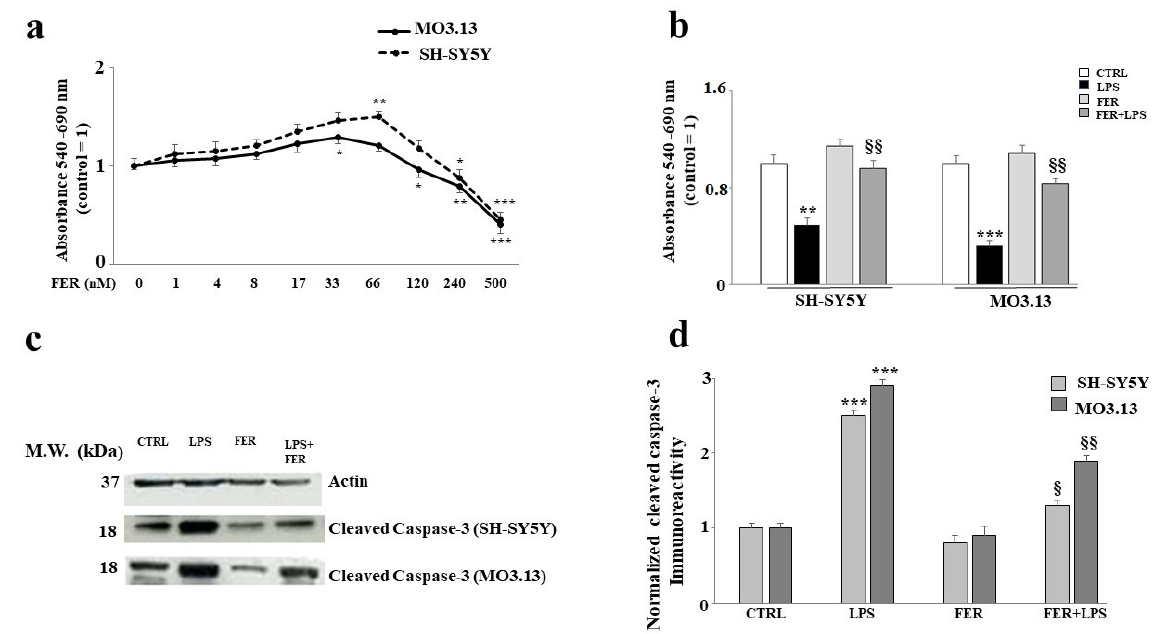
Figure 3. Role of FER in LPS-induced damage. In panel ( a ), a dose–response curve is shown for co-cultured neurons and oligodendrocytes exposed to increasing concentrations of FER over 24 h. The results made it possible to select a 33 nM dose of FER for our experimental model. Three independent experiments were carried out, with the values expressed as the mean ± standard deviation (sd). * denotes p < 0.05 vs. the control; ** denotes p < 0.01 vs. the control; *** denotes p < 0.001 vs. the control. Analysis of Variance (ANOVA) was followed by a Tukey–Kramer comparison test. Panel ( b ) shows the reversal effect of LPS-induced damage by FER, similar to that generated by 17- β -E2. Three independent experiments were carried out, and the values are expressed as the mean ± standard deviation (sd). ** denotes p < 0.01 vs. the control; *** denotes p < 0.001 vs. the control; §§ denotes p < 0.01 vs. LPS. Analysis of Variance (ANOVA) was followed by a Tukey–Kramer comparison test. In panel ( c ), the expression of cleaved caspase 3 in both cell lines (based on the indicated treatments) is displayed. Relative quantification is highlighted in panel ( d ). Three independent experiments were carried out, and the values are expressed as the mean ± standard deviation (sd). *** denotes p < 0.001 vs. the control; § denotes p < 0.05 vs. LPS; §§ denotes p < 0.01 vs. LPS. Analysis of Variance (ANOVA) was followed by a Tukey–Kramer comparison test.